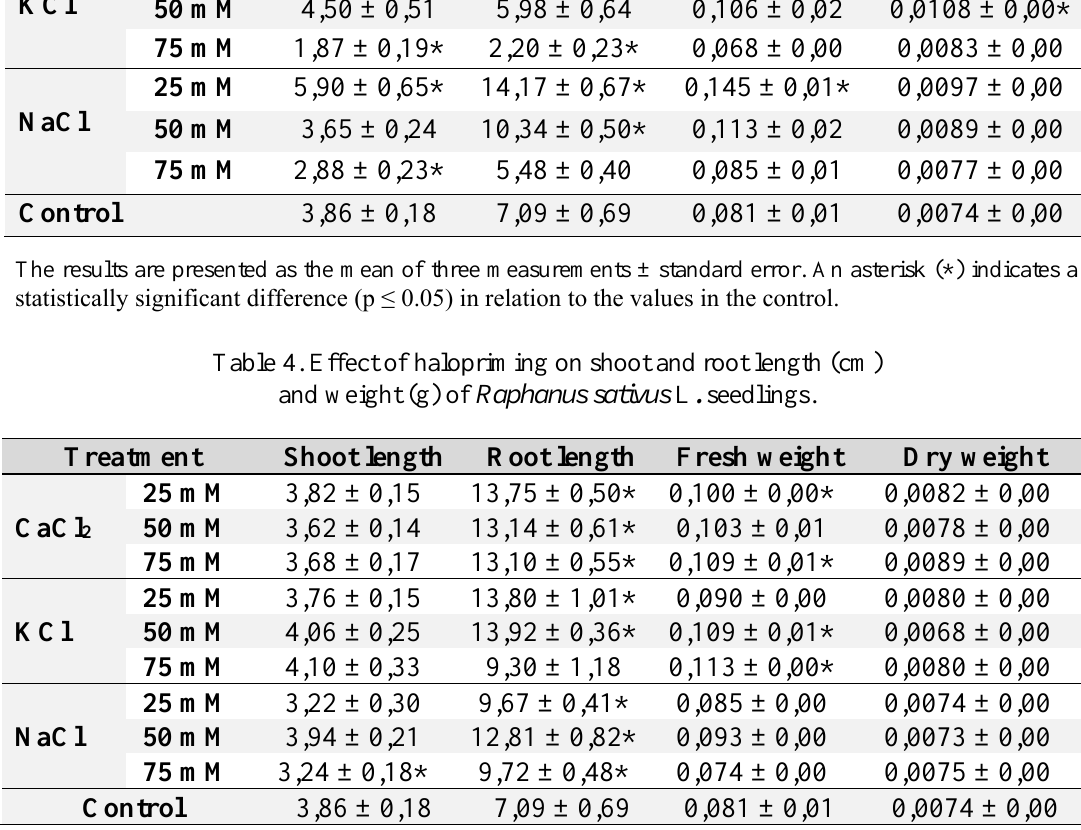
Table 3. Effect of different concentrations of CaCl